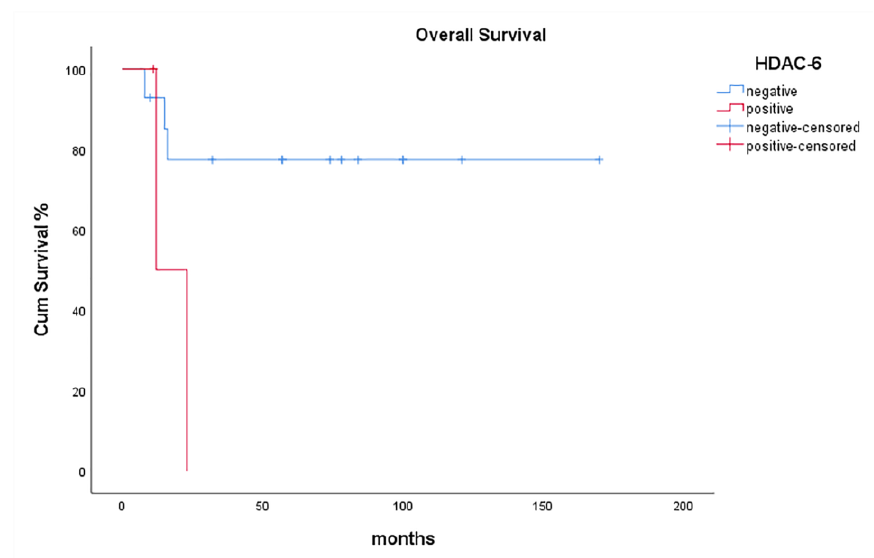
Figure 6. Kaplan-Meier survival analysis stratified according to HDAC-6 positivity in patients with HG malignant SGTs.